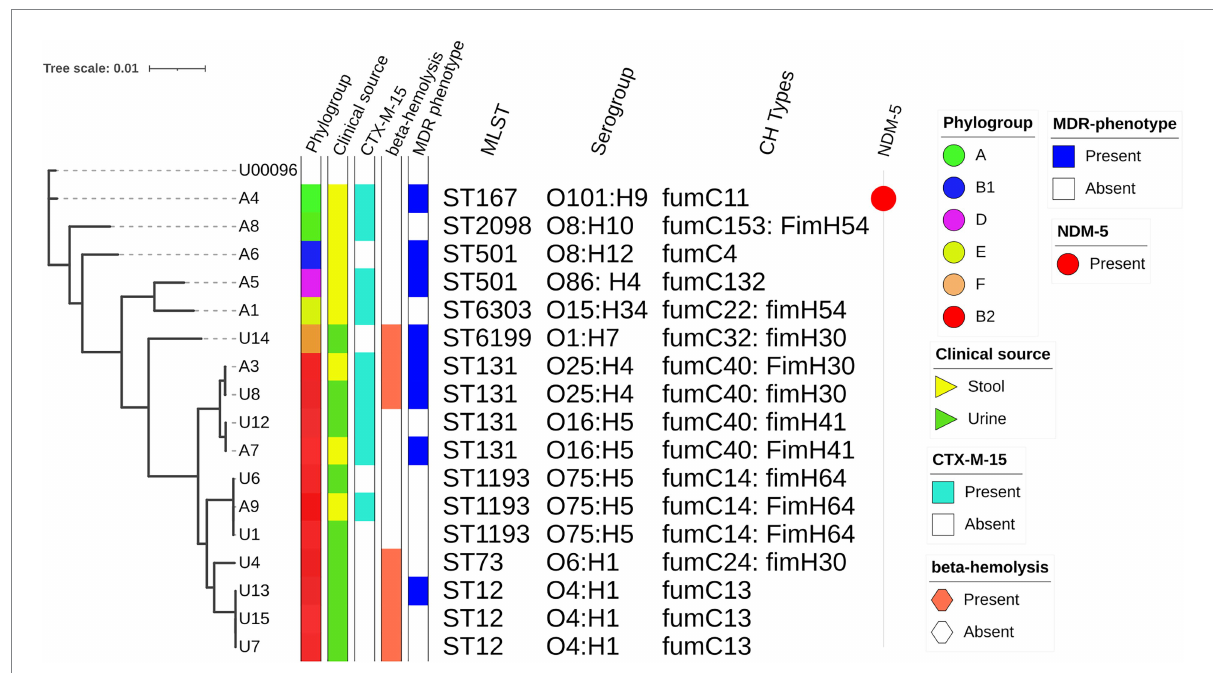
FIGURE 1 Phylogenetic relationships amongst sequenced NLF E. coli genomes. The maximum likelihood phylogenetic tree is based on the alignment of detected core genome SNPs of 17 NLF E. coli genomes with the MG1655 genome strain as a reference genome. The phylogroups, clinical source, bla CTX-M-15 status, beta-hemolysis, MDR status, STs, serogroups, CH types and bla NDM-5 status are shown to the right of the